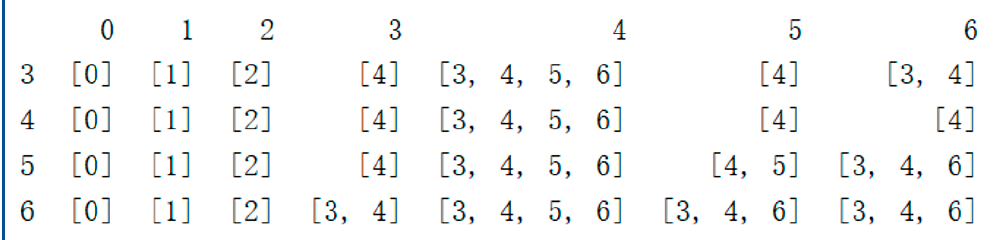
Figure 8. Lower half (running result of Python).